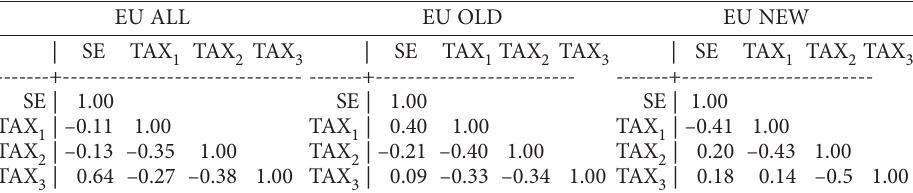
, TAX and TAX ) 1 2 3